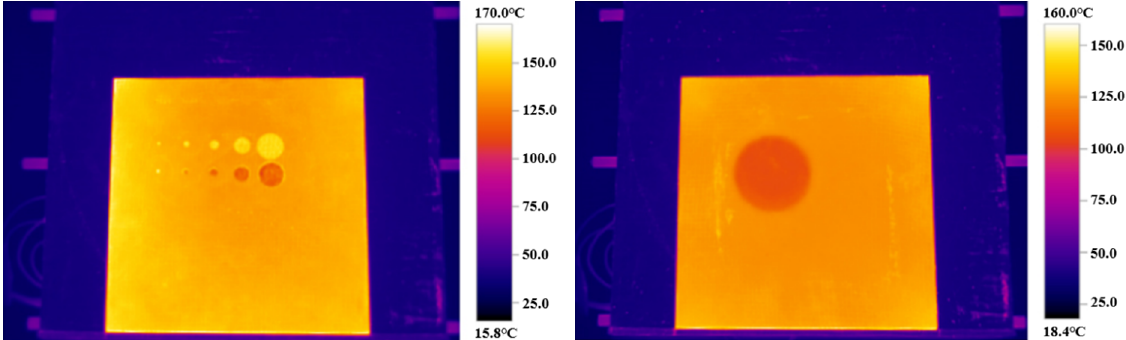
Figure 4. Infrared chart at 181.1 °C, respectively.